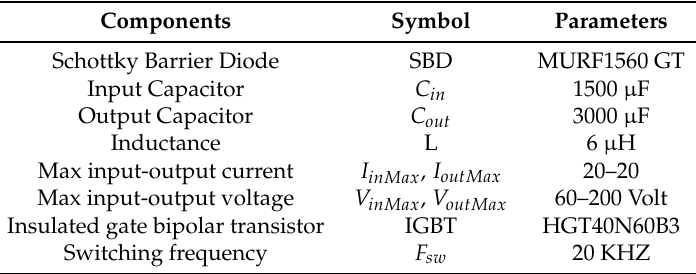
Table 2. Step-up converter characteristics.